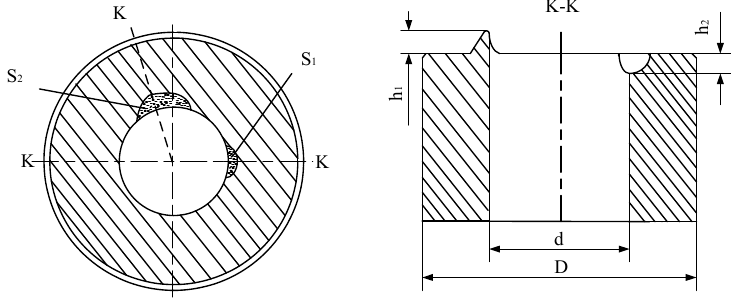
Figure 9. Schematic diagram of the evaluation method for tube fracture quality.